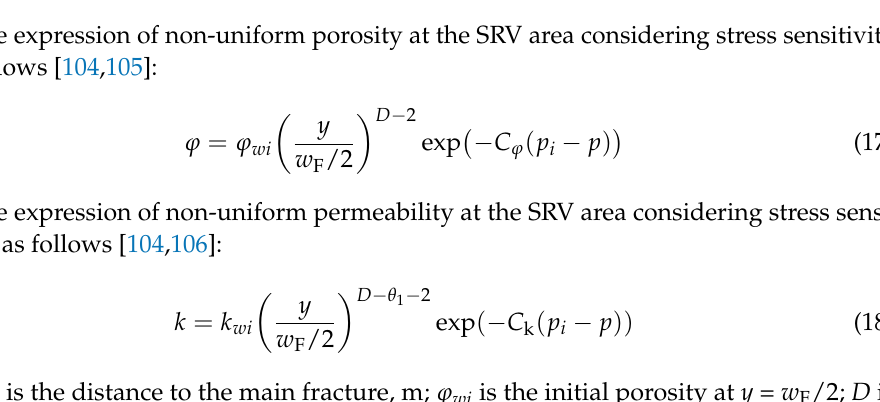
Figure 10. Diagram of reservoir heterogeneity at the SRV area.